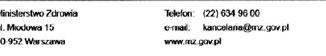
Figure 4. A letter dated 13 June 2017 addressed to the Hirszfeld Institute director forwarding a request from the Belgian Minister of Public Health regarding phage therapy in Poland (in Polish/Eng- lish).